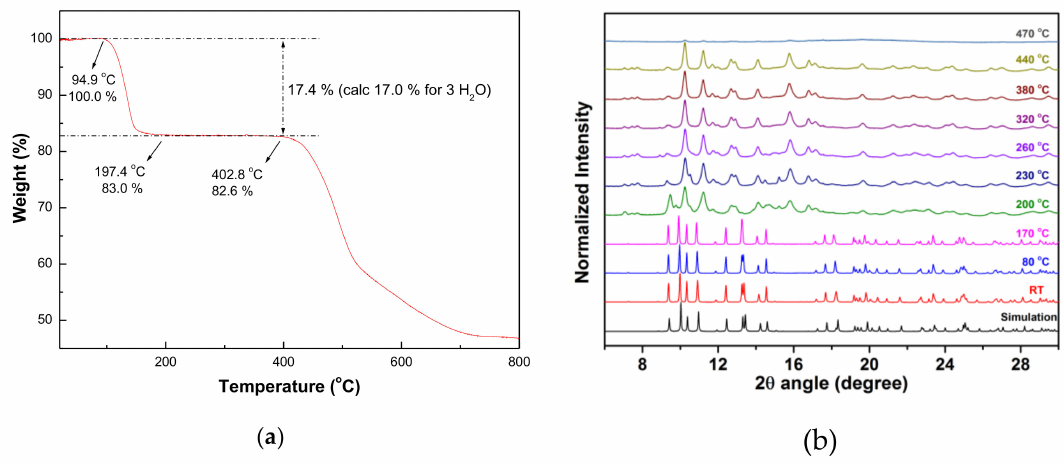
Figure 4. ( a ) TGA and ( b ) in-situ temperature dependent powder XRD measurements of 2 .